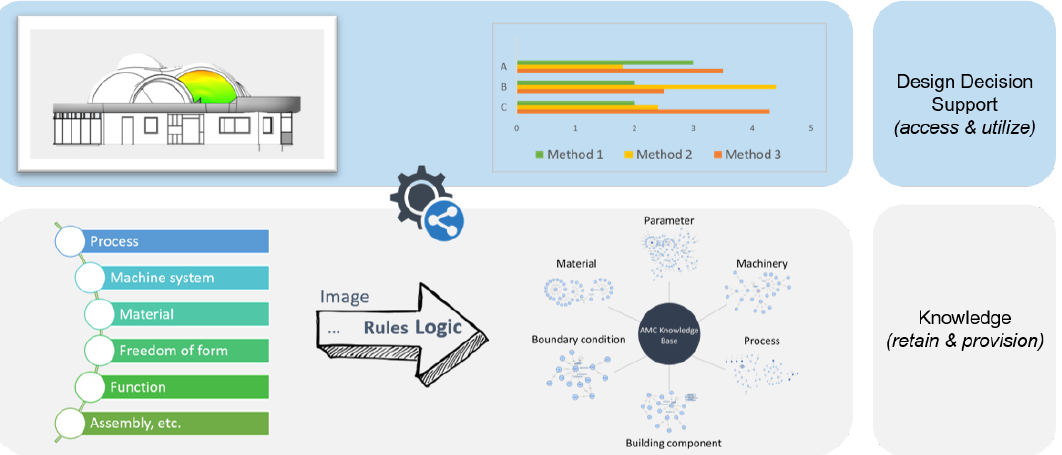
Figure 1. Concept of the Design Decision Support System.